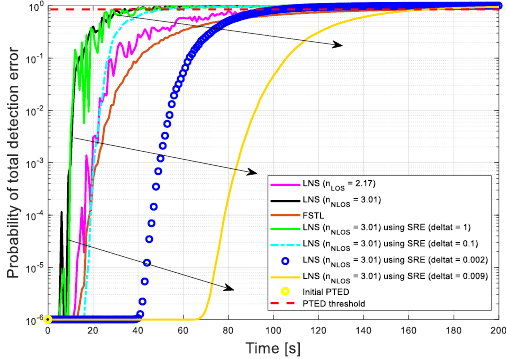
Figure 6 . Probability of total detection error vs. Time [s].